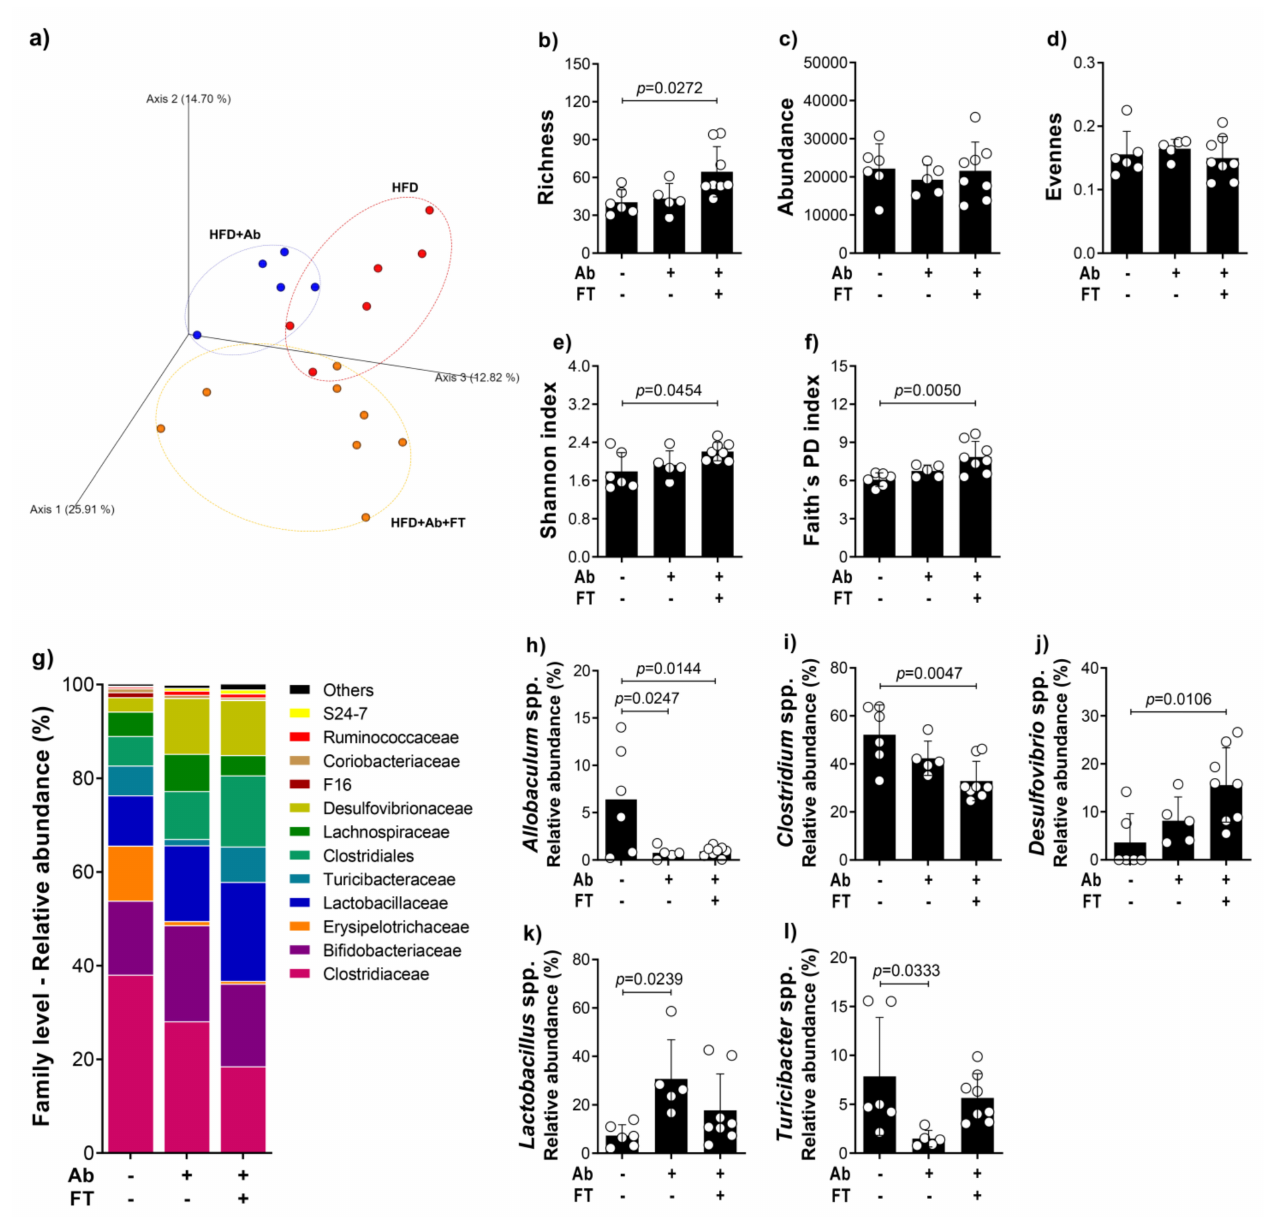
Figure 5. Fecal transplantation from obese mice restores obesity-induced dysbiosis. ( a ) Principal coordinate analysis (PCoA) plots based on unweighted (qualitative) phylogenetic UniFrac distance matrices, ( b ) richness, ( c ) absolute abundance, ( d ) evenness, ( e ) Shannon index, ( f ) Faith’s phylogenetic diversity index, ( g ) relative abundance at family levels and relative abundance of genera ( h ) Allobaculum , ( i ) Clostridium , ( j ) Desulfovibrio , ( k ) Lactobacillus and ( l ) Turicibacter of fecal bacterial OTUs. Data are representative of two independent experiments and are expressed as means ± SD. Bars show the significant difference between groups ( p <